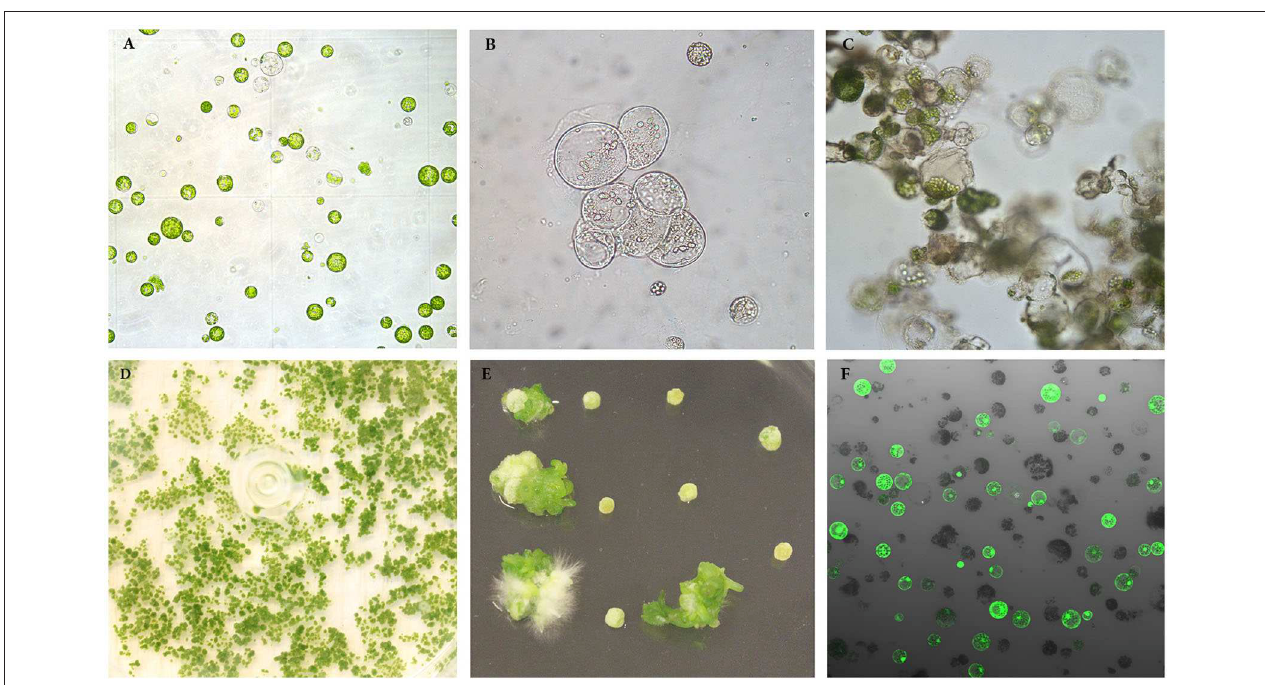
FIGURE 1 | Isolation, regeneration and transfection of protoplasts of rapeseed. (A) Freshly isolated protoplasts. (B, C) Protoplasts undergoing cell divisions and multiplication. (D) Protoplast colonies. (E) Shoot regeneration from protoplast colonies. (F) Transfected protoplasts expressing GFP protein observed under confocal laser scanning